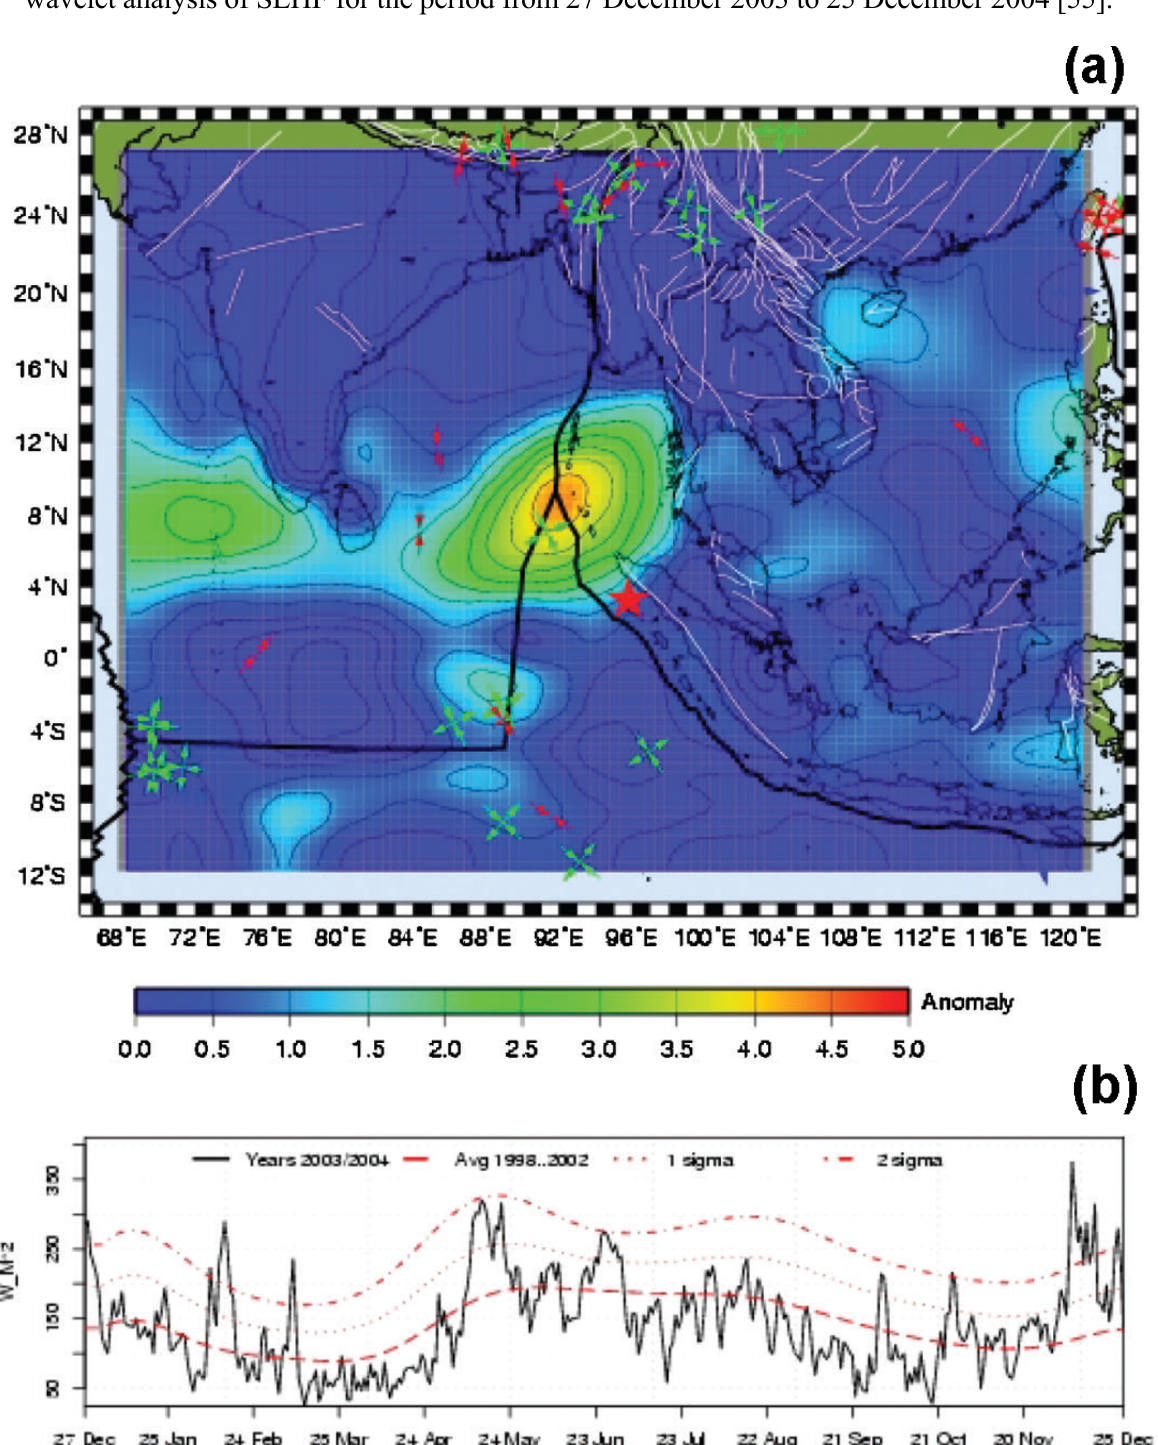
Figure 18. Surface latent heat flux anomalies for the Sumatra earthquake (M = 9.0, 26 December 2004, Indonesia). (a) SLHF anomaly on 7 December 2004. (b) Time series of wavelet analysis of SLHF for the period from 27 December 2003 to 25 December 2004